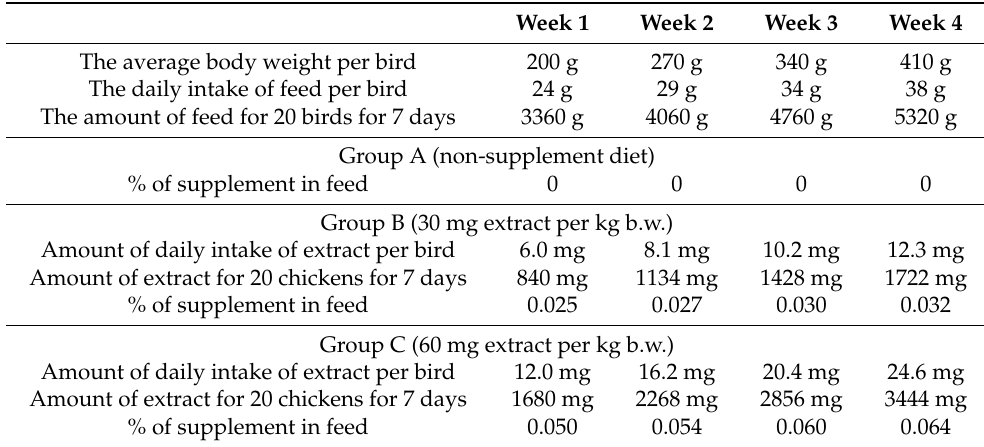
Table 4. Preparation of supplemented